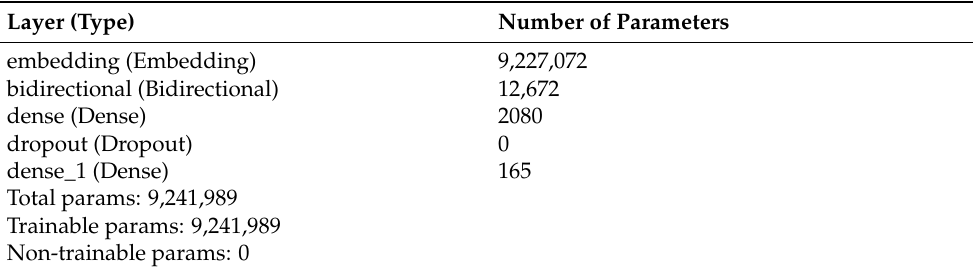
Figure 5. The proposed review classification model. Table 5. The proposed deep learning model’s layers and the corresponding number of